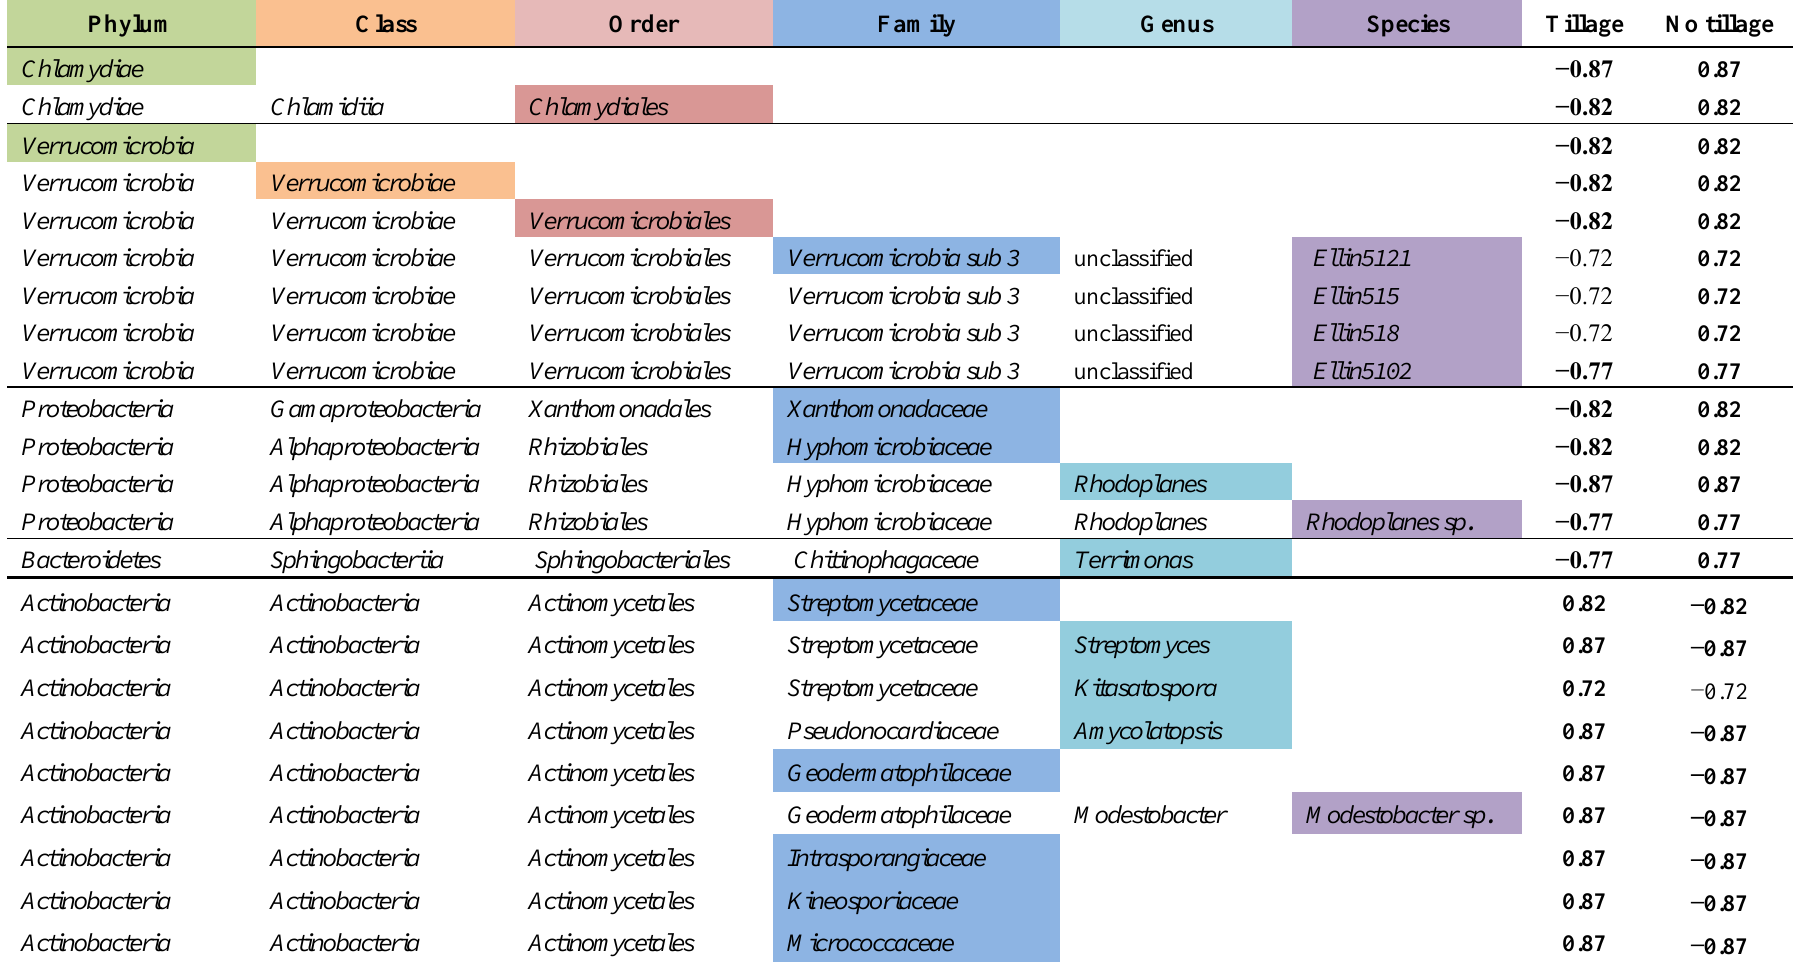
Table 3. Spearman correlations ( p -value ≤ 0.01) of the most correlated organisms with conventional tillage and no-tillage. The correlated microorganisms are within the colorful boxes. The names in gray color represent the correlated microorganism’s related